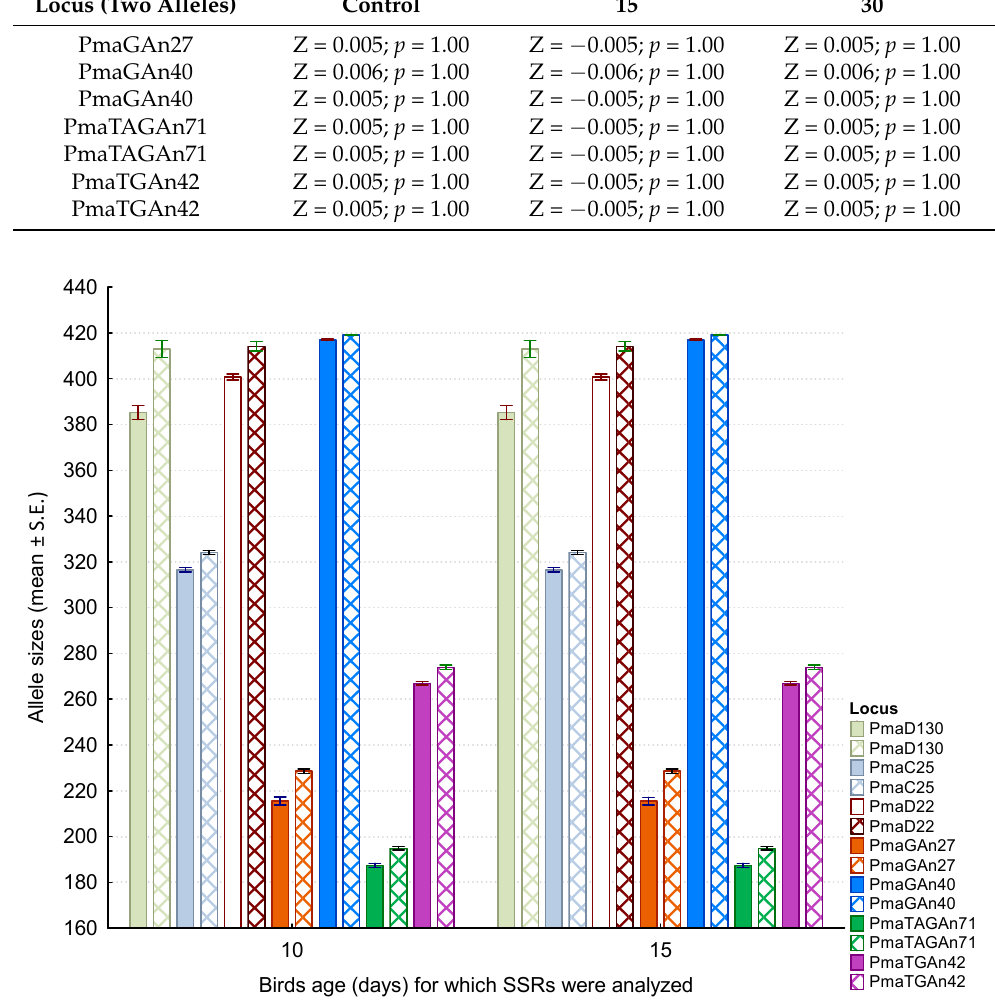
Figure 2. Allele sizes (mean ± S.E.) recorded for SSRs genotyped twice in 5-day interval for nestlings, which were supplemented with a dose of 15 µg Pb/g of body weight.